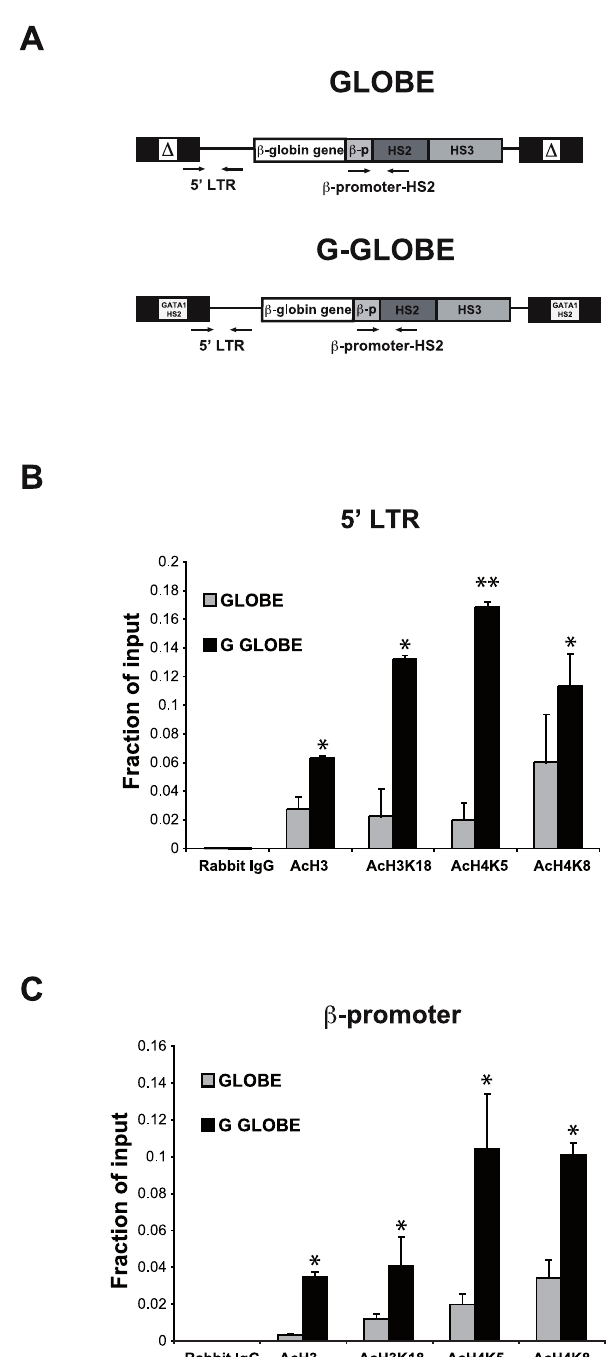
Figure 7. Increased CBP-mediated histone acetylation levels at GATA1 -HS2-containing LV. ChIP assay was carried out in GLOBE- and G-GLOBE-transduced HEL cells using antibodies against pan-acetylated histone H3, acetylated histone H3K18, acetylated histone H4K5, and acetylated histone H4K8. (A) Map of GLOBE and G-GLOBE proviruses Arrows indicate the primer pairs used to amplify the 5 9 LTR and the b - globin promoter-HS2 region. The acetylation levels are significantly higher at the 5 9 LTRs (B) and at the b -globin promoter region (C) of GATA1 -HS2-containing LV compared to the GLOBE vector. (n=4). *P , 0.05; **P , 0.01 by Student t test. Error bars represent